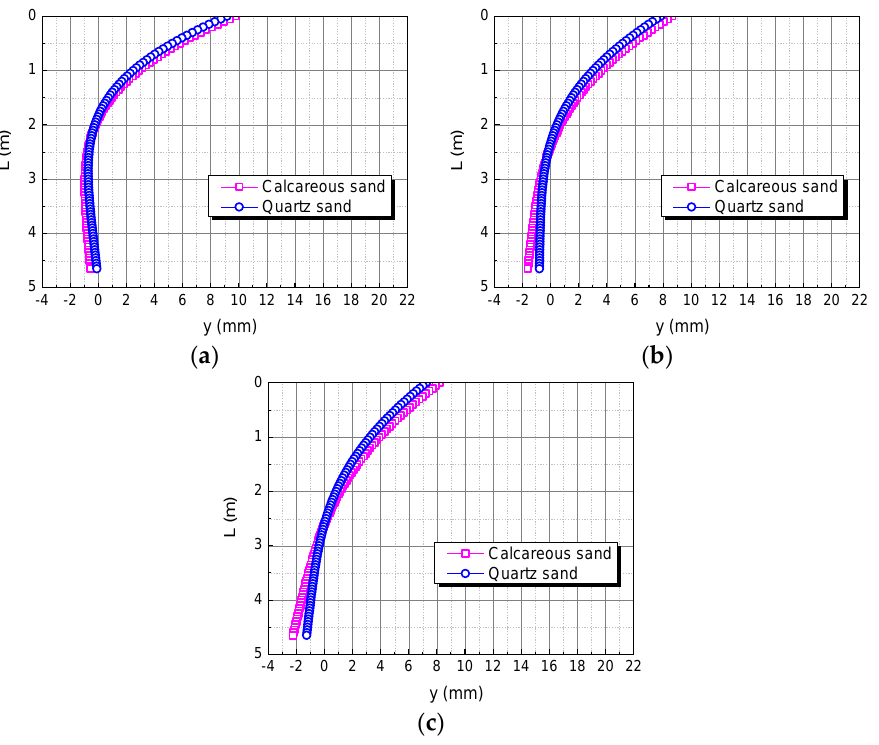
Figure 14. Effect of elastic modulus of pile on horizontal displacement of pile. ( a ) E; ( b ) 2E; ( c ) 3E.